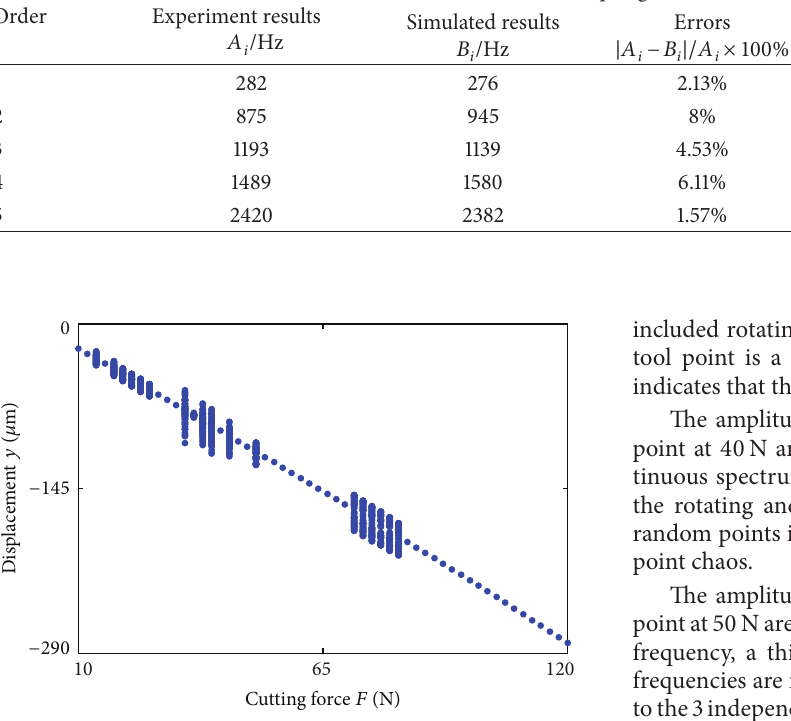
Figure 13: Global bifurcation of tool point in 𝑦 direction with different cutting